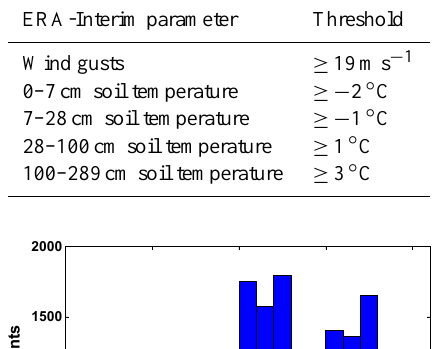
Table 1. The forest damage probability thresholds defined for the ERA-Interim dataset.